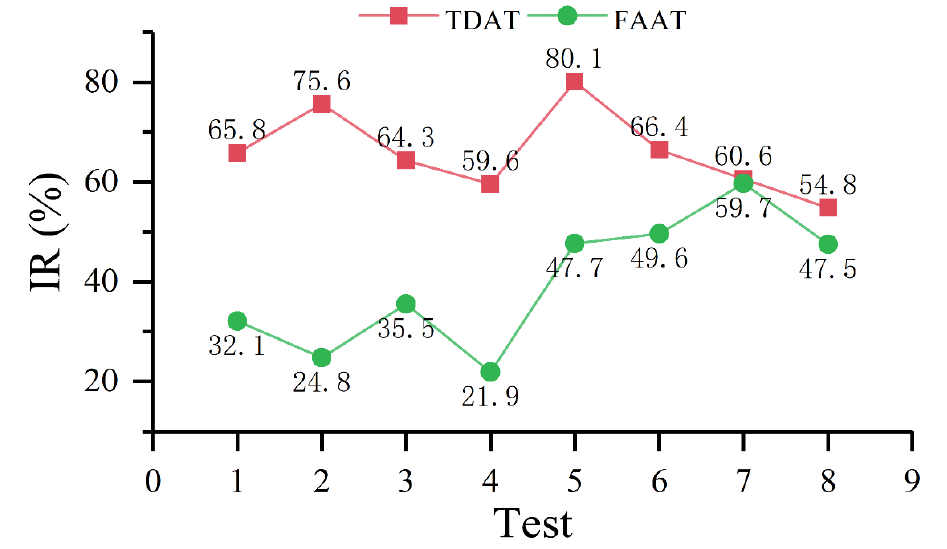
Figure 15. Quantitative statistics of IR in robustness tests.